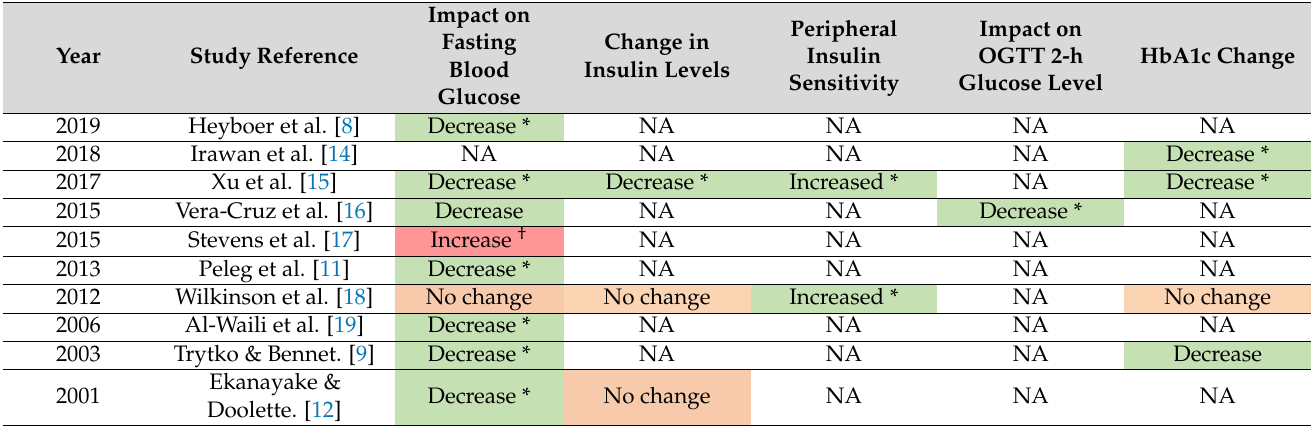
* Indicates statistical significance. † There is no evidence in this study of statistical analysis of change in blood glucose levels following HBOT. OGTT = Oral Glucose Tolerance Test, HbA1c = Glycated haemoglobin. Green background colour indicates a positive impact, red background colour indicates a negative impact and an orange background colour indicates no